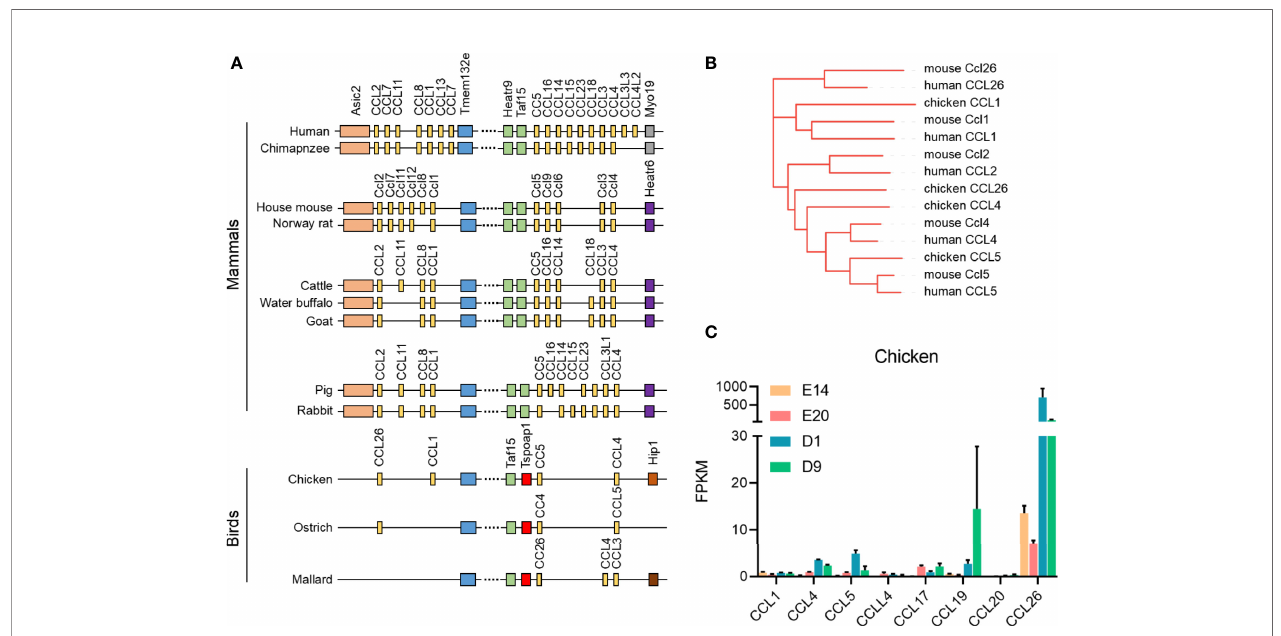
FIGURE 10 | Schematic structure of the genomic organization and expression of CCL family with representative vertebrate species. (A) Schematic structure of the genomic organization of CCL family with representative vertebrate species; (B) the phylogenetic tree of CCL26, CCL1, CCL2, CCL4, and CCL5 in human, mouse, and chicken; (C) the expression pattern of CCL family of chicken subcutaneous adipose tissue in four development